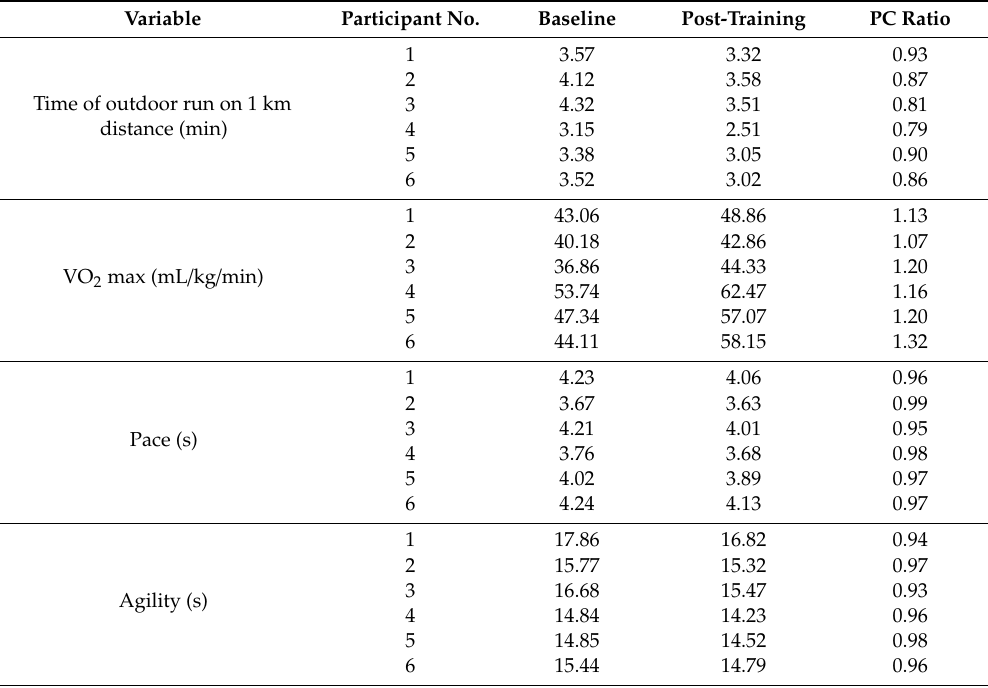
Table 1. Motor performance outcomes at baseline and post-training.